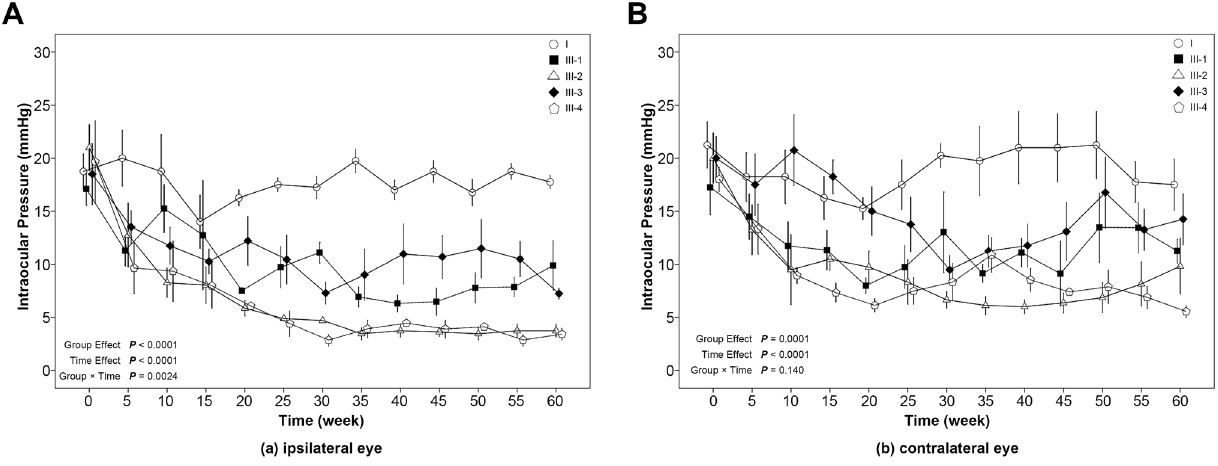
Figure 3. The effect of unilateral injection of the opioid receptor agonist, DAMGO, into the ARC on intraocular pressure in the ipsilateral eye (a) and the contralateral eye (b). 6 SE) of each group is located at time points of 0, 5, 10, 15, 20, 25, 30, 35, 40, 45, 50, 55 and 60 minutes. A slight separation was made for error-bars at the same time points to avoid overlapping. I, control group; III-1, 2 m mol/ m l DAMGO injection group; III-2, 4 m mol/ m l DAMGO injection group; III-3, subconjunctival naloxone + 2 m mol/ m l DAMGO group; III-4, subconjunctival saline + 2 m mol/ m lDAMGO group.